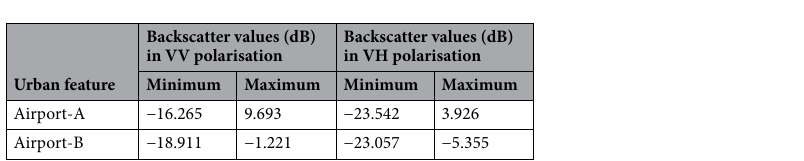
Table 15. Summary of variations in backscatter values for bridges and airport